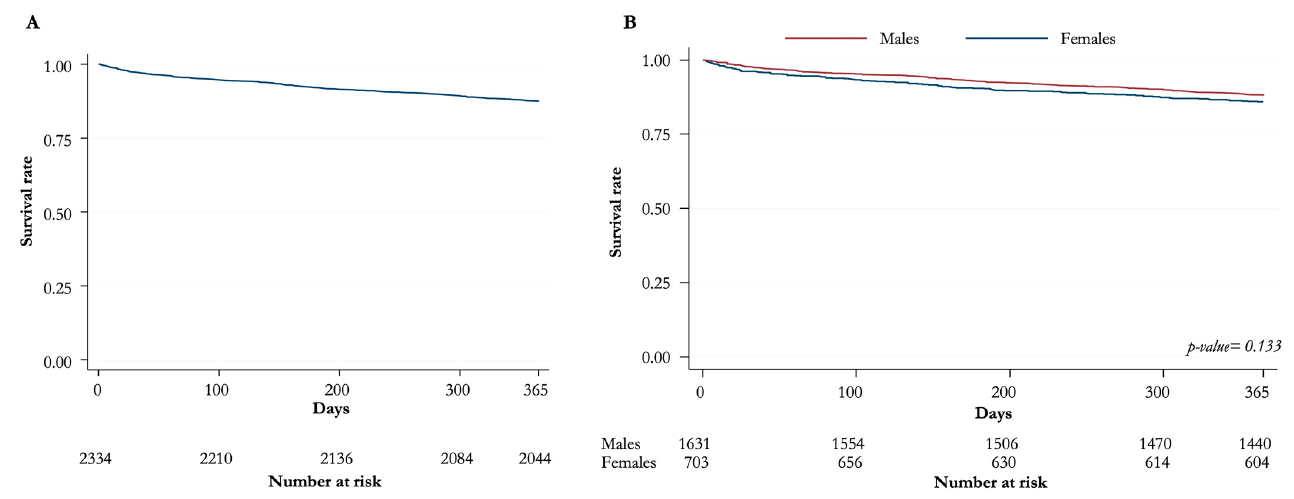
Figure 2. Kaplan–Meier curves for overall survival at 1 year. ( A ) Distribution of overall survival ( B ) Overall survival for males and females.